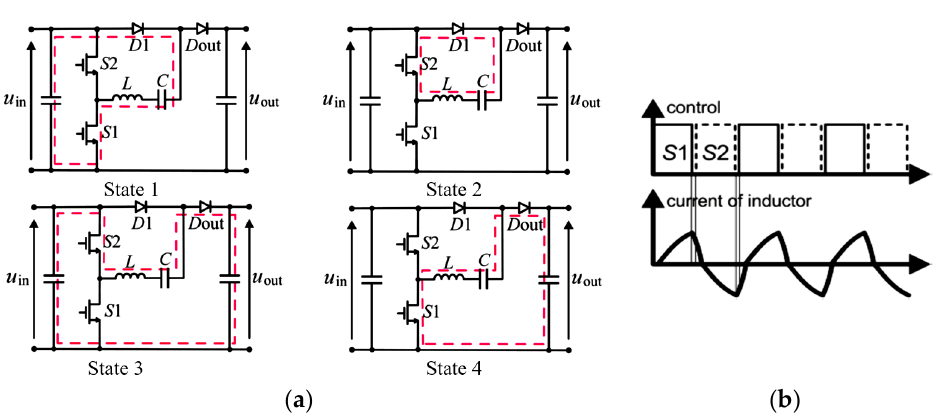
Figure 2. ( a ) Operating states of SCVD in charging and discharging cycles of the switched capacitor. ( b ) Idealized control signals and inductor current waveforms. Pattern P2.